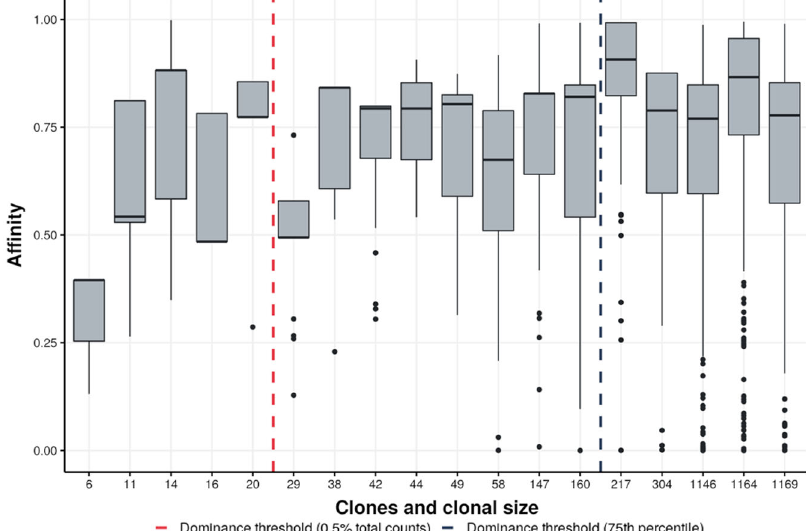
Fig. 7 Clonal af fi nity at day 21. Boxplots representing clonal af fi nity, showing the large variation in subclonal af fi nity for 18 surviving clones in the GC at day 21 of a representative simulation (Simulation 1; Supplementary Table 2). The boxplots are sorted and labeled according to the cell count of their corresponding clone. A strong correlation between clonal abundance and af fi nity that we expected to result from clonal expansion in combination with af fi nity maturation, is absent. In addition, we also observe highly abundant but low-af fi nity clones and vice versa. Horizontal line: median. Boxes: 25th and 75th percentiles. Whiskers: 1.5 times the interquartile range. Dots: outliers. The top 5 clones are dominant according to the threshold of ≥ = 75th percentile of clonal abundances (blue) while the top 13 clones are dominant according to the threshold of ≥ = 0.5% of the cell counts (red).